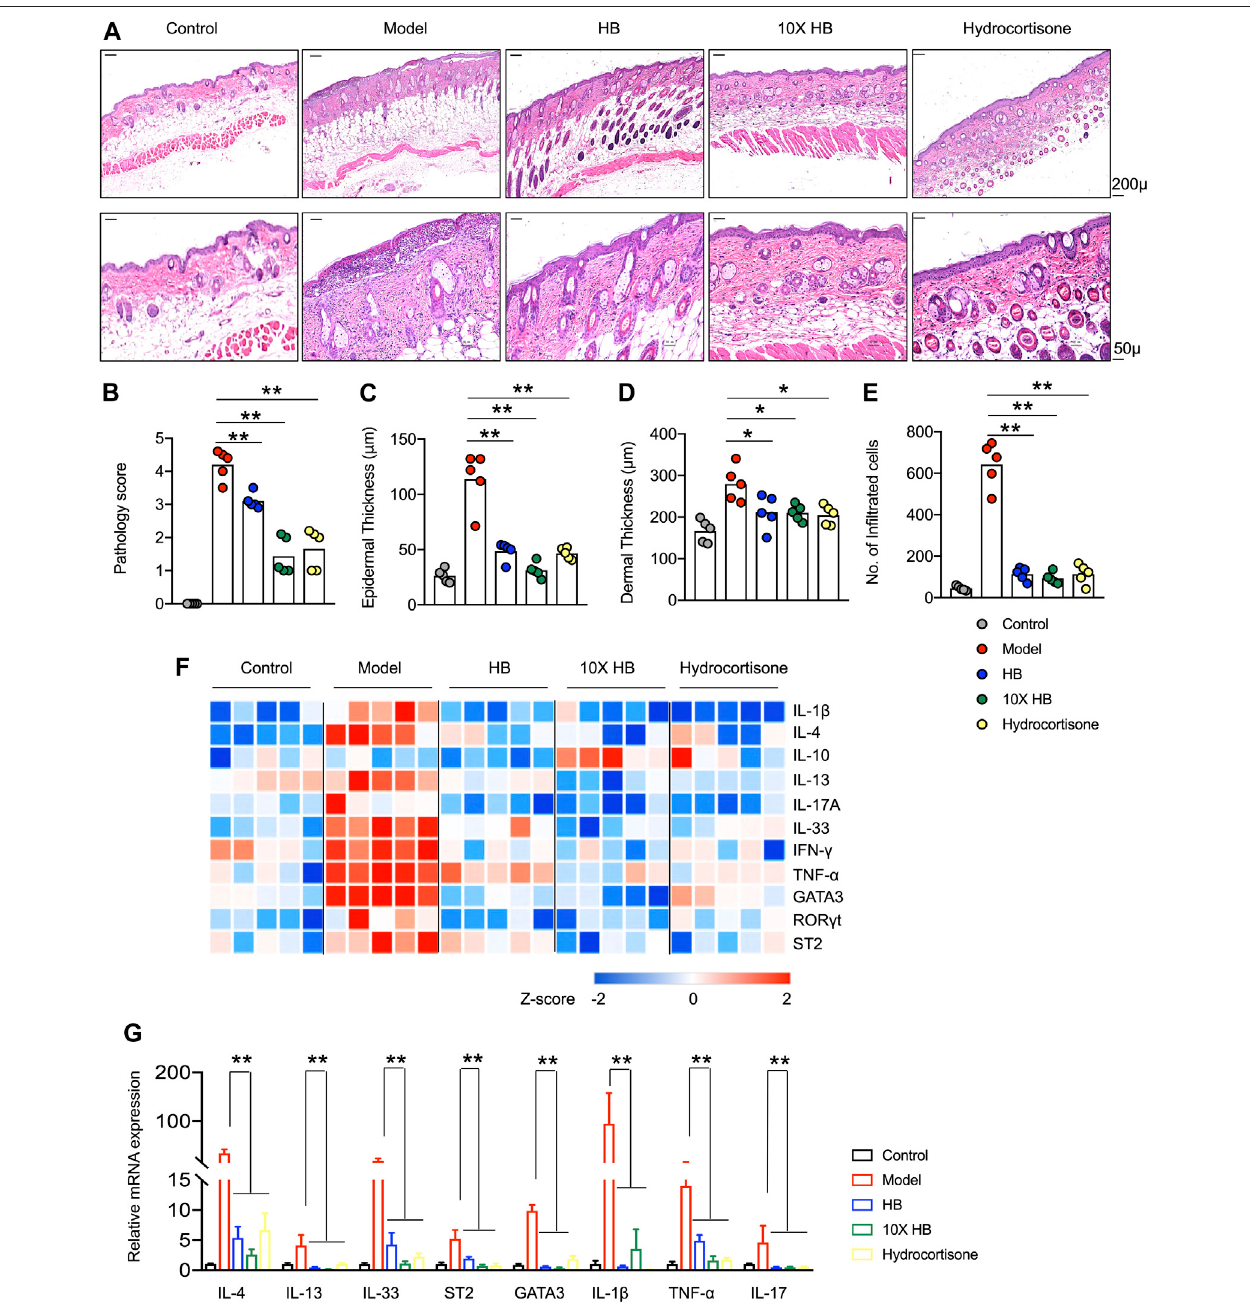
FIGURE2| HBreduces AD-likeskinin fl ammationand thetype2immuneresponseinducedbyDNCBinmice.Miceweresensitizedwith1%DNCBondorsalskin at days 0 and 3 and then challenged with 0.4% DNCB on the dorsum of both ears at 3 day intervals from days 5 to 20. HB, 10X HB (a 10-fold concentration of HB), hydrocortisone,orPBSwastopicallyapplieddailytothedorsalskinoftheseDNCB-inducedmice. (A) HistopathologyofmousedorsalskintissuewasevaluatedbyH&E staining (scale bars, 50 or 200 μ M). Representative images in each group are shown. Pathology scores were blindly evaluated, and statistics are shown in (B) . (C – E) ImagePro10softwarewasusedtomeasureandcalculateepidermalthickness (C) ,dermalthickness (D) ,andnumberofin fi ltratedcells (E) . (F) Geneexpressionin skin tissue from fi ve individual mice in each group, measured by qPCR and shown in a heatmap. Blue represents low expression, and red represents high expression of each in fl ammatory gene compared between three groups, with Row Z-Score ( − 2 – 2). (G) Type 2 cytokines and transcription factors in skin tissues were measured by qPCR. Each dot represents onemouse from one ofthree independentexperiments, and bars indicate mean values. Statistical signi fi cance was determined byone-way ANOVA, * p < 0.05, ** p <